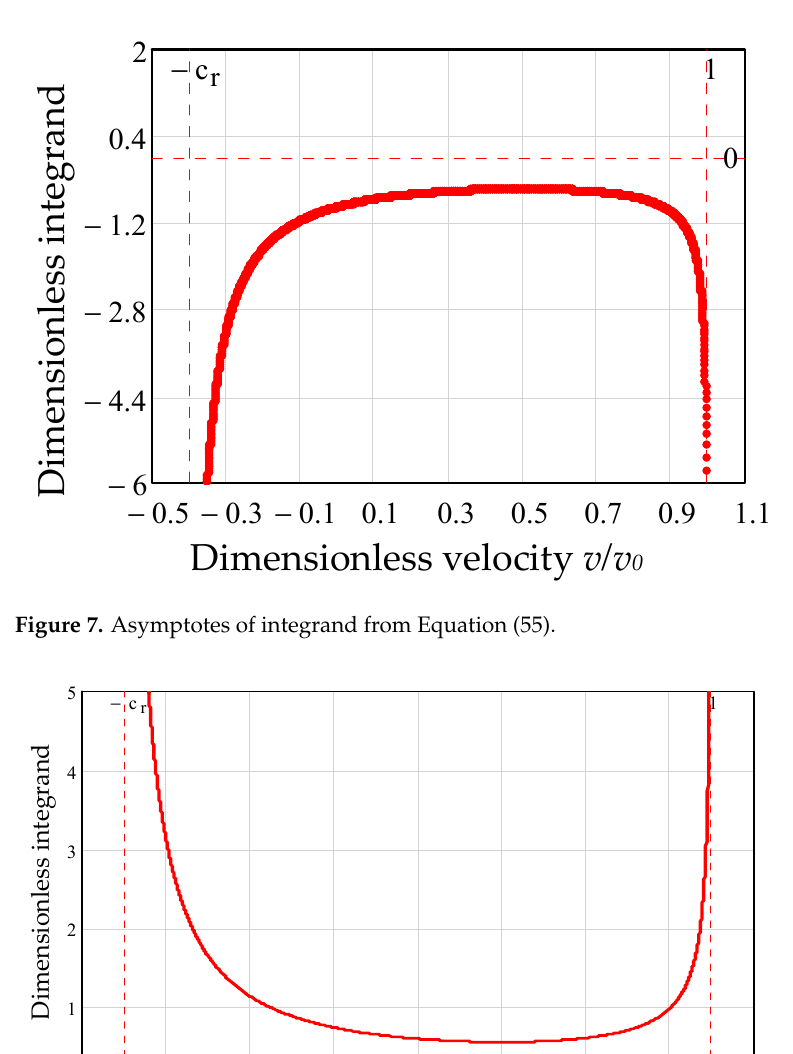
Figure 8. Asymptotes of integrand from Equation (56).